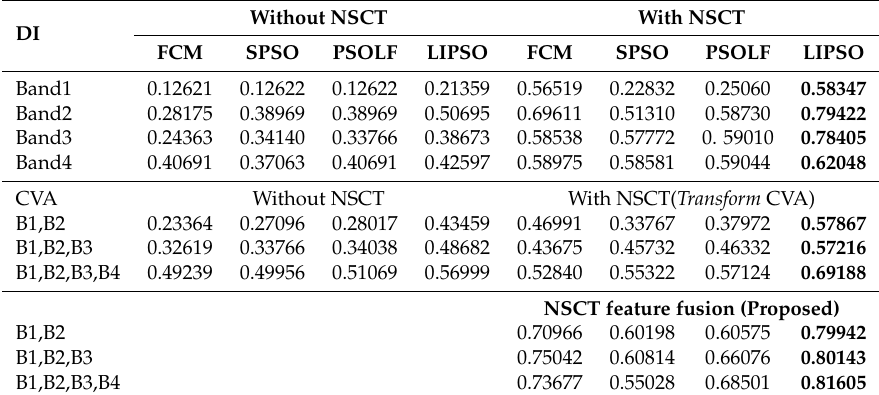
Table 4. Kappa statistic obtained for FCM [3], SPSO [47], PSOLF [43], LIPSO (proposed) of Malambuzha Dam, Kerala data set for with and without NSCT decomposition.